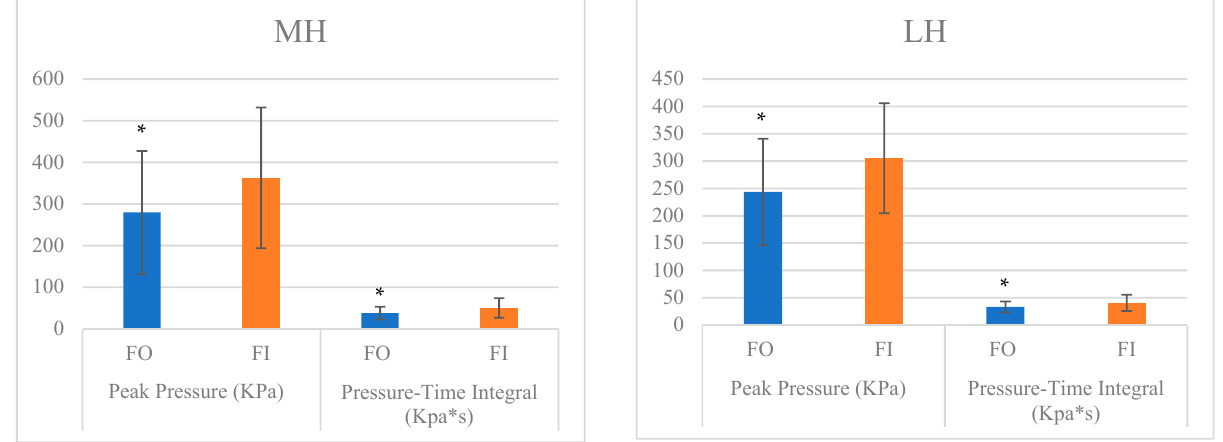
Figure 6. Plantar pressure of medial heel (MH) and lateral heel (LH) with customized foot orthosis (FO) or flat insoles (FI). * p < 0.05.